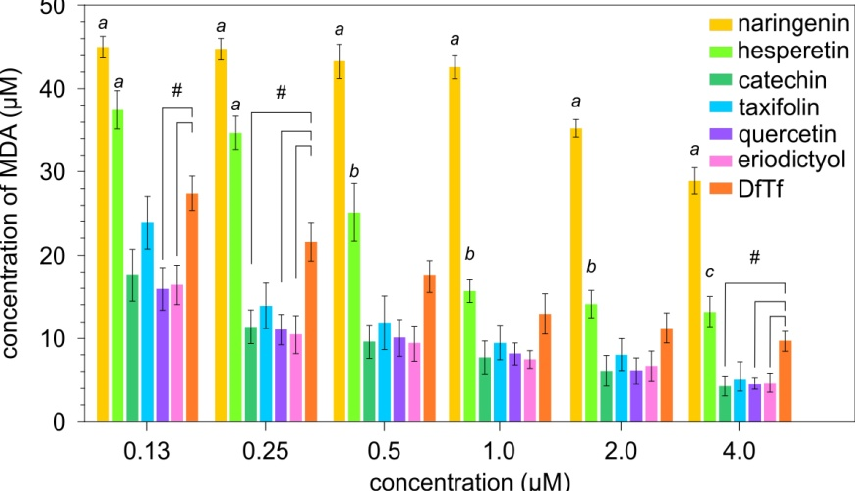
Figure 5. Effect of polyphenols on lipid peroxidation. a differences are significant compared with other compounds; b differences are significant compared with catechin, quercetin, eriodictyol, and naringenin; c differences are significant compared with other compounds, with the exception of DfTf; # significant differences between the compounds, p < 0.05.